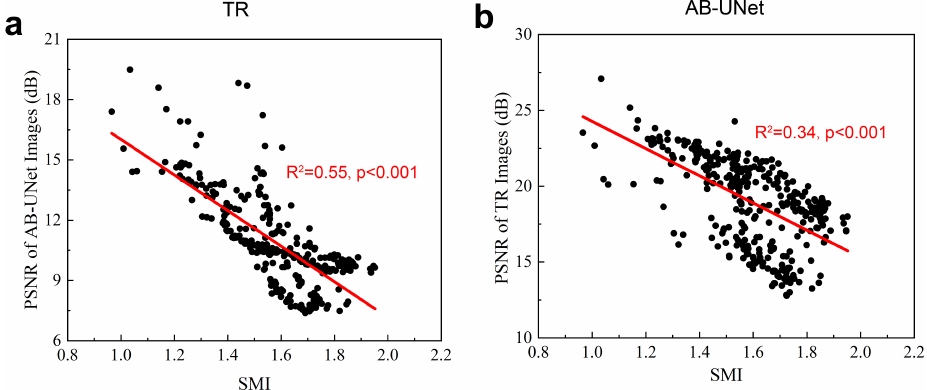
Figure 8. ( a ) Scatter plots of the relationship between SMI and the performance of TR reconstruction, and ( b ) performance of AB-U-Net reconstruction. The red lines are the fitting curves of linear regression, where R 2 is the coefficient of determination, and p is the possibility